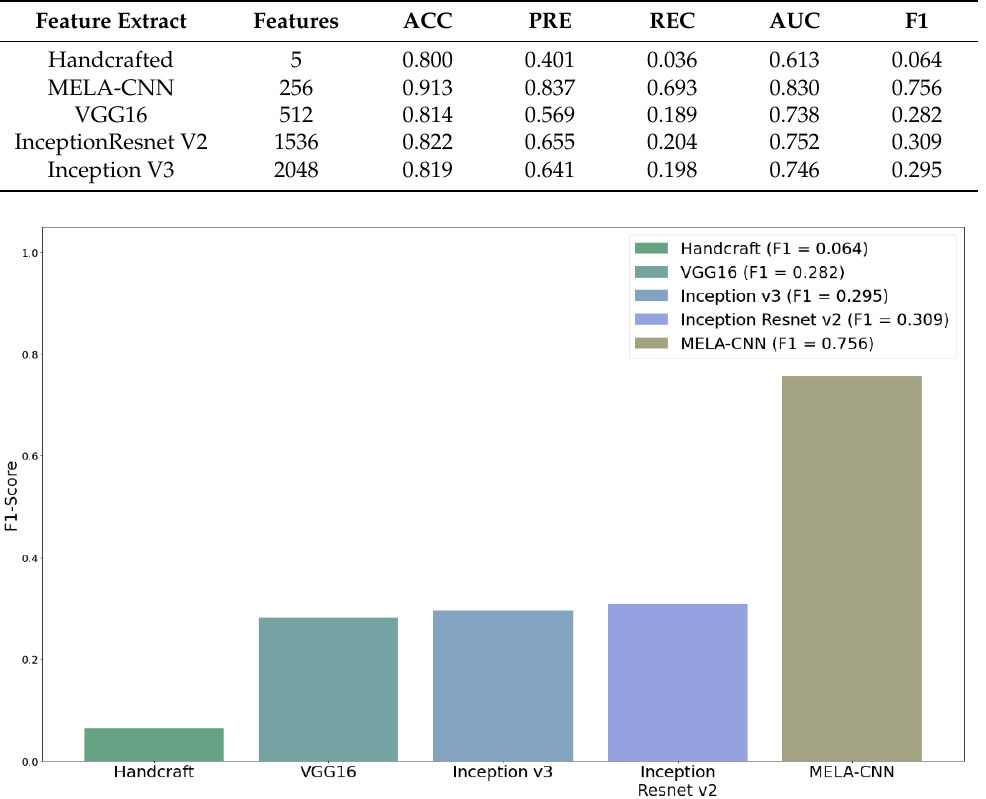
Table 2. Performance evaluation of five feature extraction techniques.